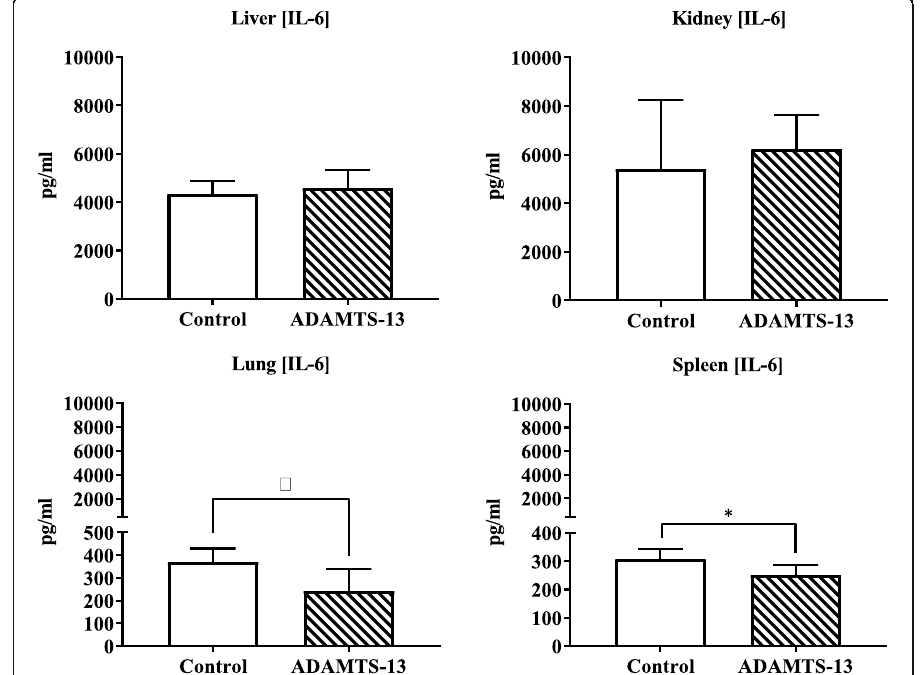
Fig. 5 Parameters of organ-specific inflammation. IL-6 levels measured in organ homogenates. Values are presented as median and IQR. * p < 0.05, † p <